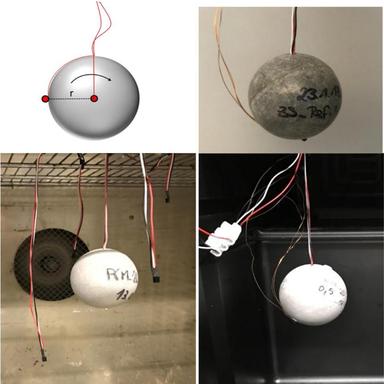
Details of the spherical samples, position of the thermocouples and sample arrangement inside the oven.